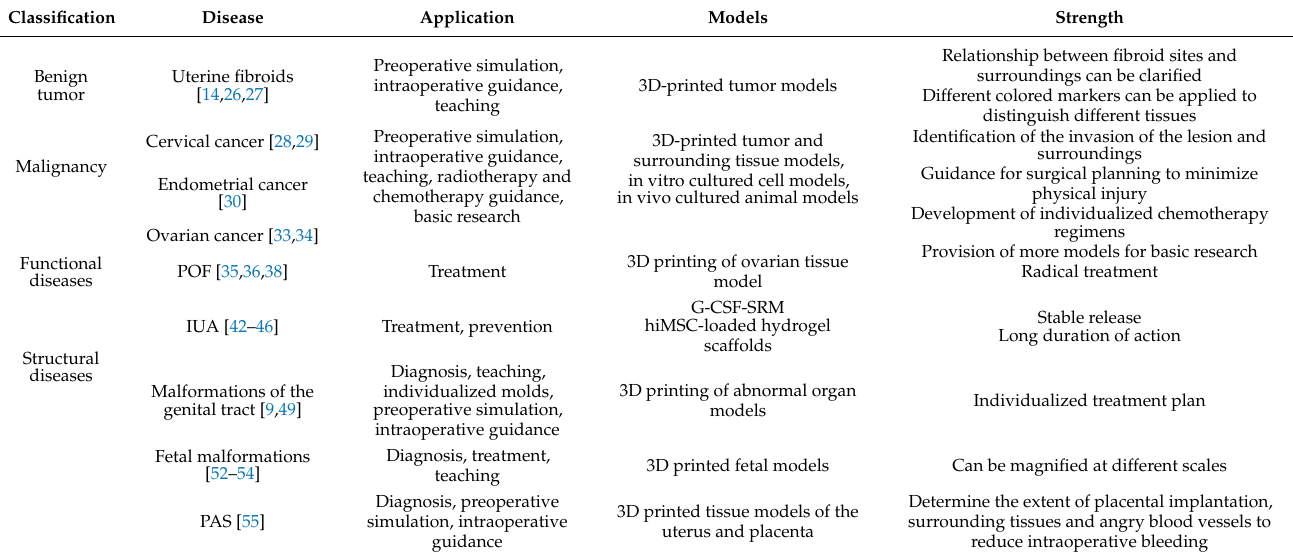
Table 4. The applications of 3D printing technology in obstetrics and